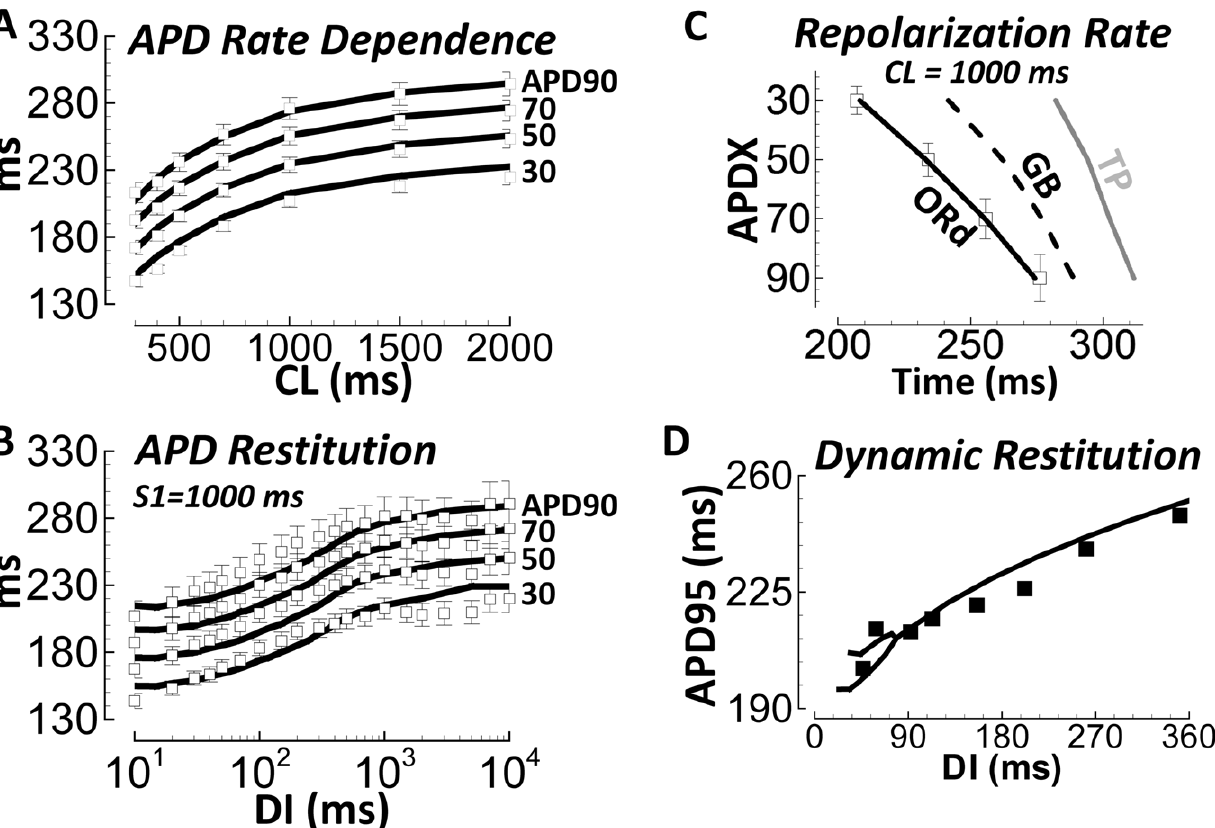
Figure 7. Undiseased human endocardial AP response to pacing protocols from experiments (small tissue preparations) and model simulations. A) Steady state APD rate dependence. B) S1S2 APD restitution (DI – diastolic interval). APD30–90 are labeled at right. Solid lines are simulation results; white squares are experiments at 37 u C (N=140 hearts in panel A, N=50 hearts in panel B). C) Repolarization rate at CL=1000 ms. Trajectory of APD30 to APD90 is accurate in the ORd model (white squares are experimental data); less so in other models. D) Dynamic restitution protocol (see Methods). Experiments are from Koller et al.[58], measured in nonfailing human hearts with monophasic AP electrodes (black squares). Simulated results are the black line. At very short diastolic intervals (DI , 90 ms), the model shows APD bifurcation (alternans).